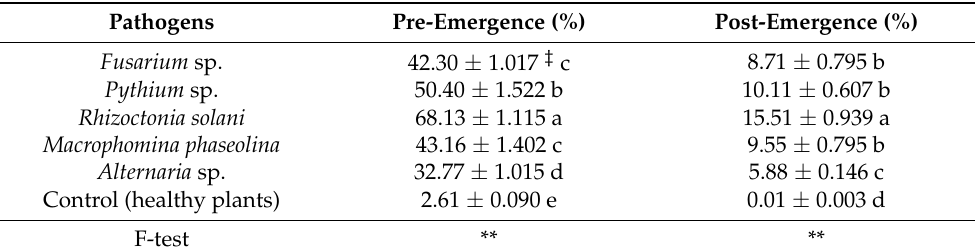
Table 2. Pathogenicity of different pathogens isolated from tomato seedlings under greenhouse